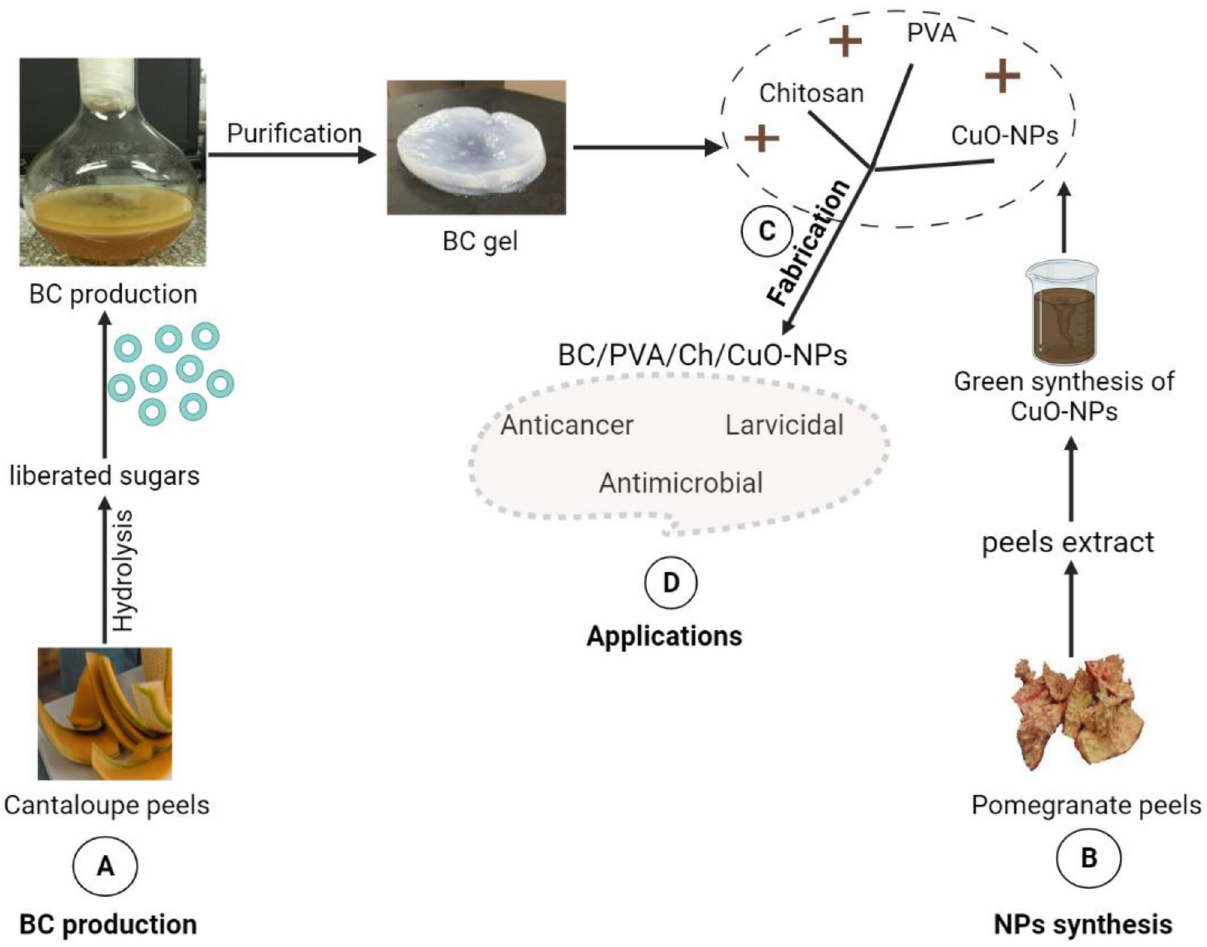
Figure 1. Schematic representation of the four main steps in the present study: ( A ) synthesis of BC using CP media, ( B ) green synthesis of CuO-NPs using POP extract, ( C ) fabrication of the resulting BC membrane with PVA and Ch, and ( D ) potential composite applications ( D